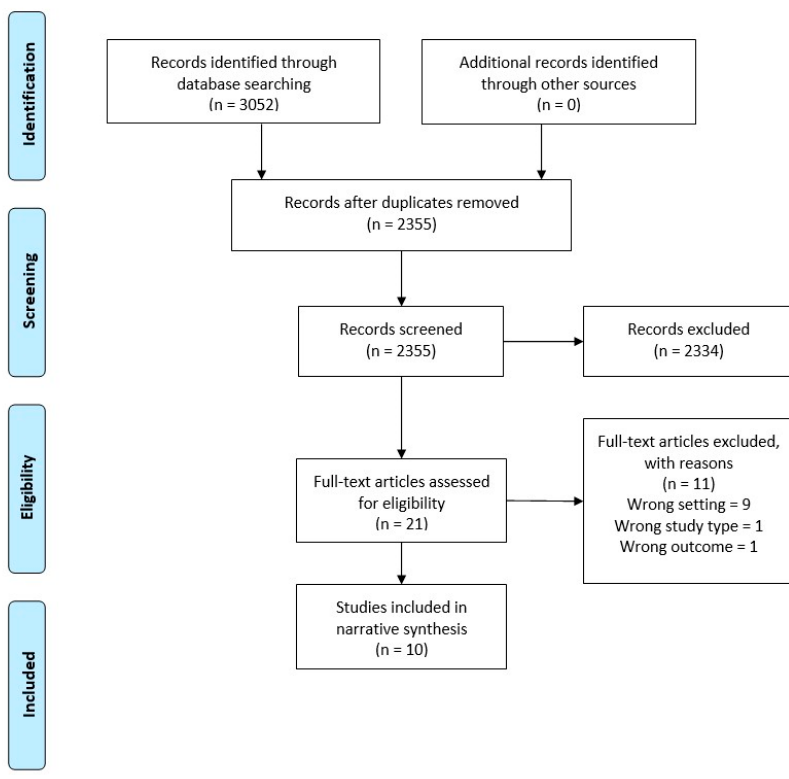
Figure 1. Preferred Reporting Items for Systematic Reviews and Meta-Analyses (PRISMA) Flow Diagram—Umbrella Review.